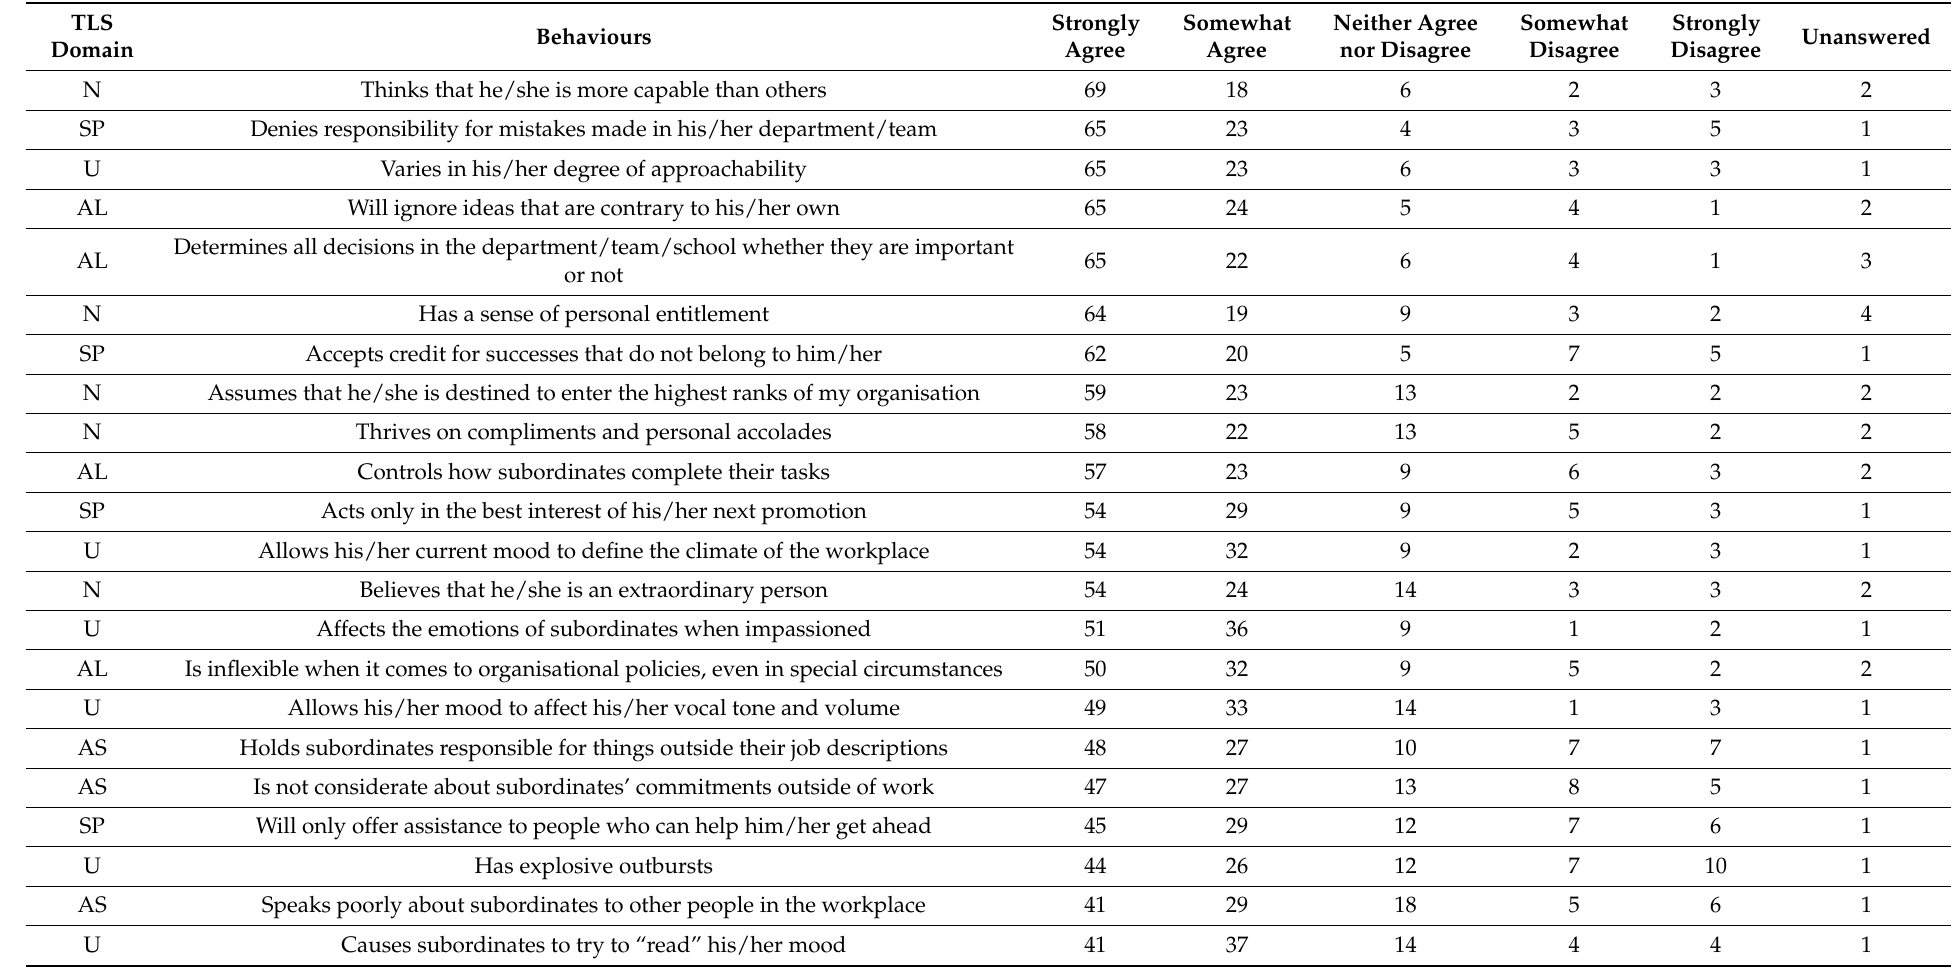
Table 6. Percentage representation of TLS © behaviours sorted by “strongly agree” in descending